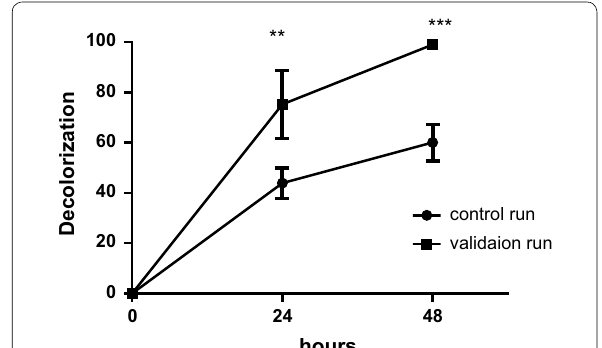
Fig. 6 Decolorization of Remazol black B by isolate B1 in the control run with media composition and under conditions before optimiza- tion [4 g K 2 HPO 4 ; 4 g KH 2 PO 4 ; 2 g (NH 4 ) 2 SO 4 ; 0.5 g MgSO 4